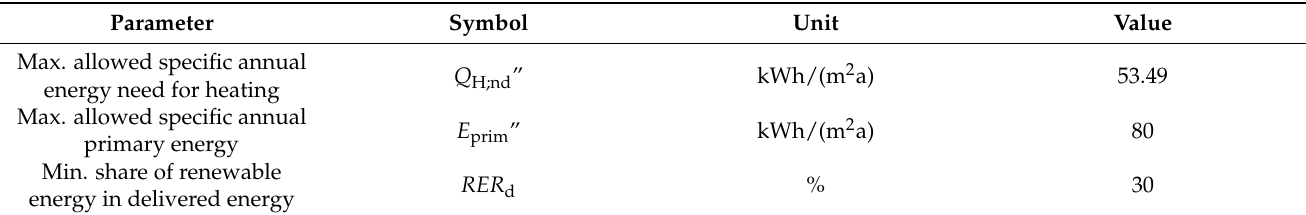
Table 3. Requirements for nZEB multi-apartment building in Croatia.